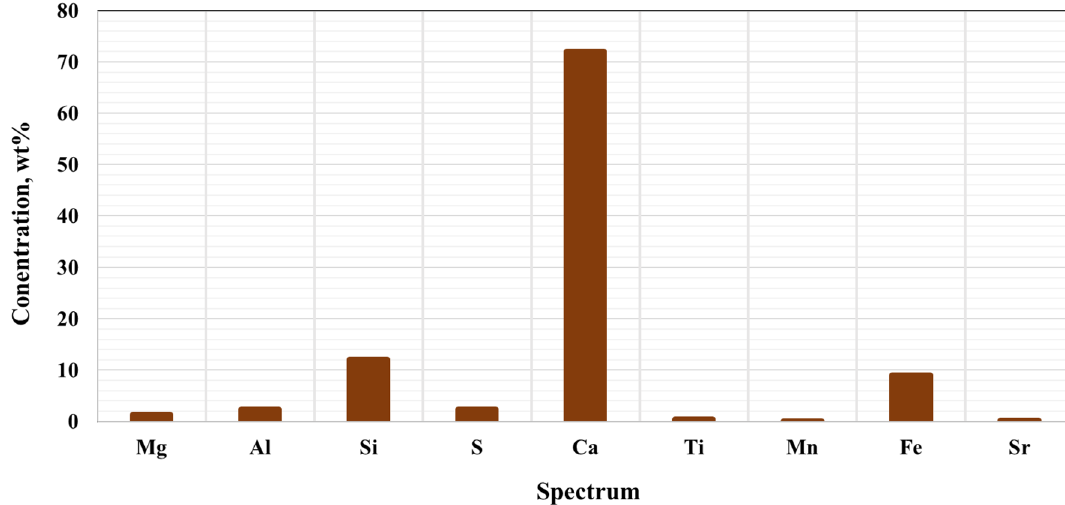
Fig. 2 Class G cement's composition performed by